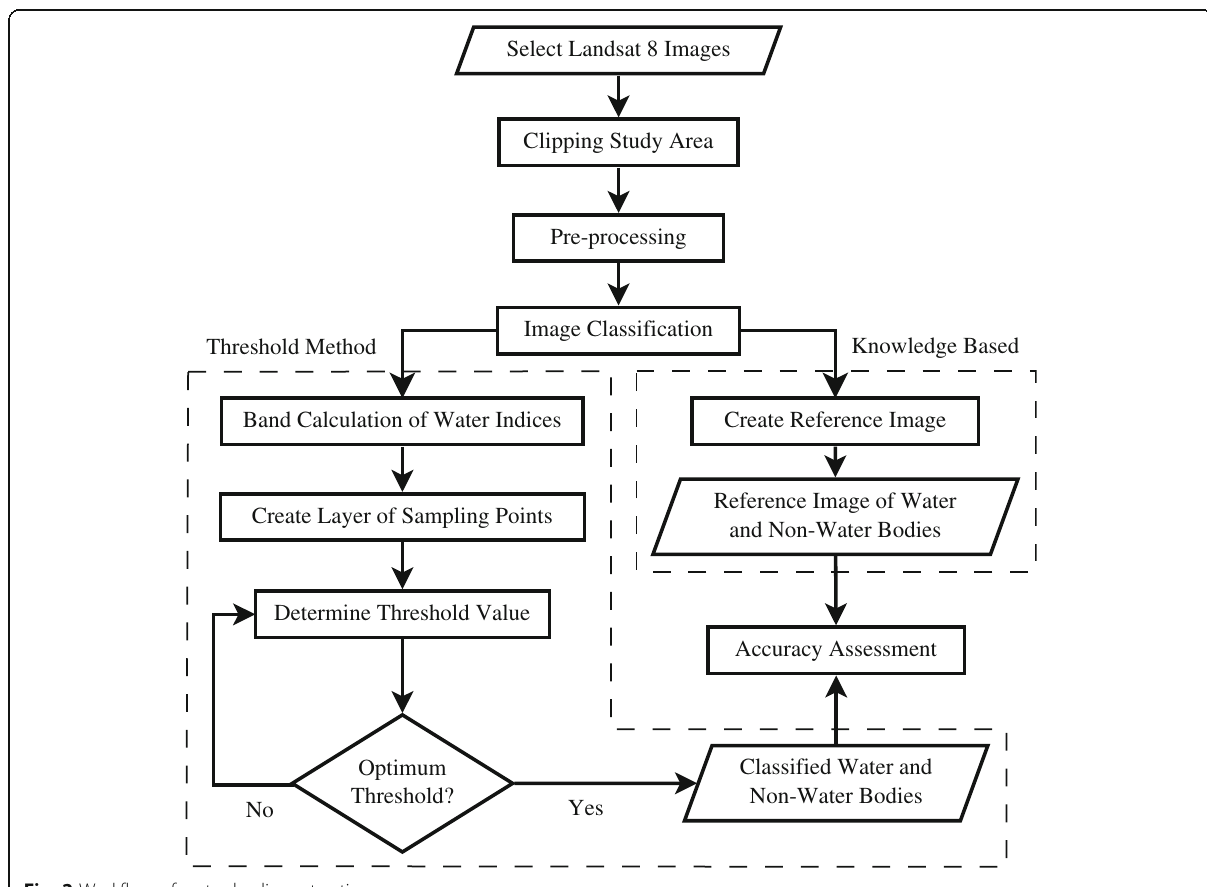
Fig. 2 Workflow of water bodies